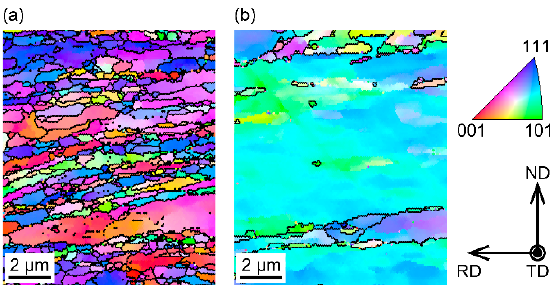
Figure 4. IPF maps of the rolled specimen of ( a ) fine grains and ( b ) coarse grains. Metals 2020 , 10 , x FOR PEER REVIEW